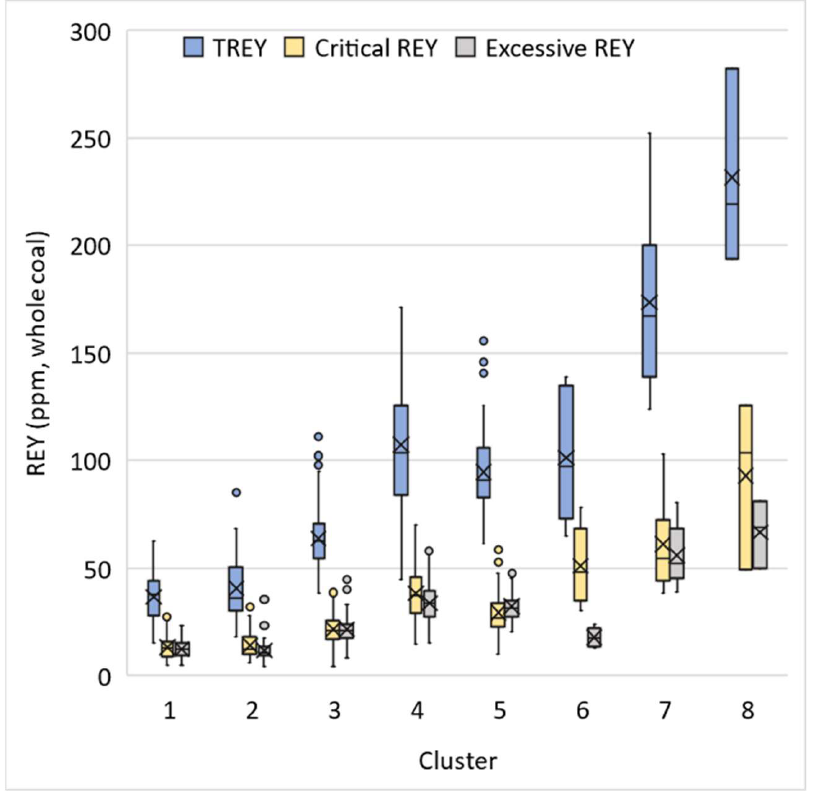
Figure 9. Boxplot showing whole coal total REY, critical REY, and excessive REY for K-means clus- ters. Mean values are represented by an “X”. Mean values are represented by an